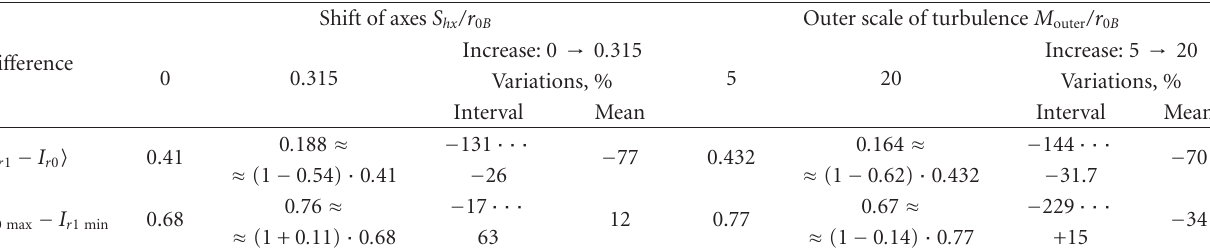
Table 2: Influence of optical axes shift S hx and outer scale M outer of turbulence on di ff erence I r 0max − I r 1min and mean di ff erence (cid:5) I r 1 − I r 0 (cid:6) of functions I r 1 ( N r ) and I r 0 ( N r ).